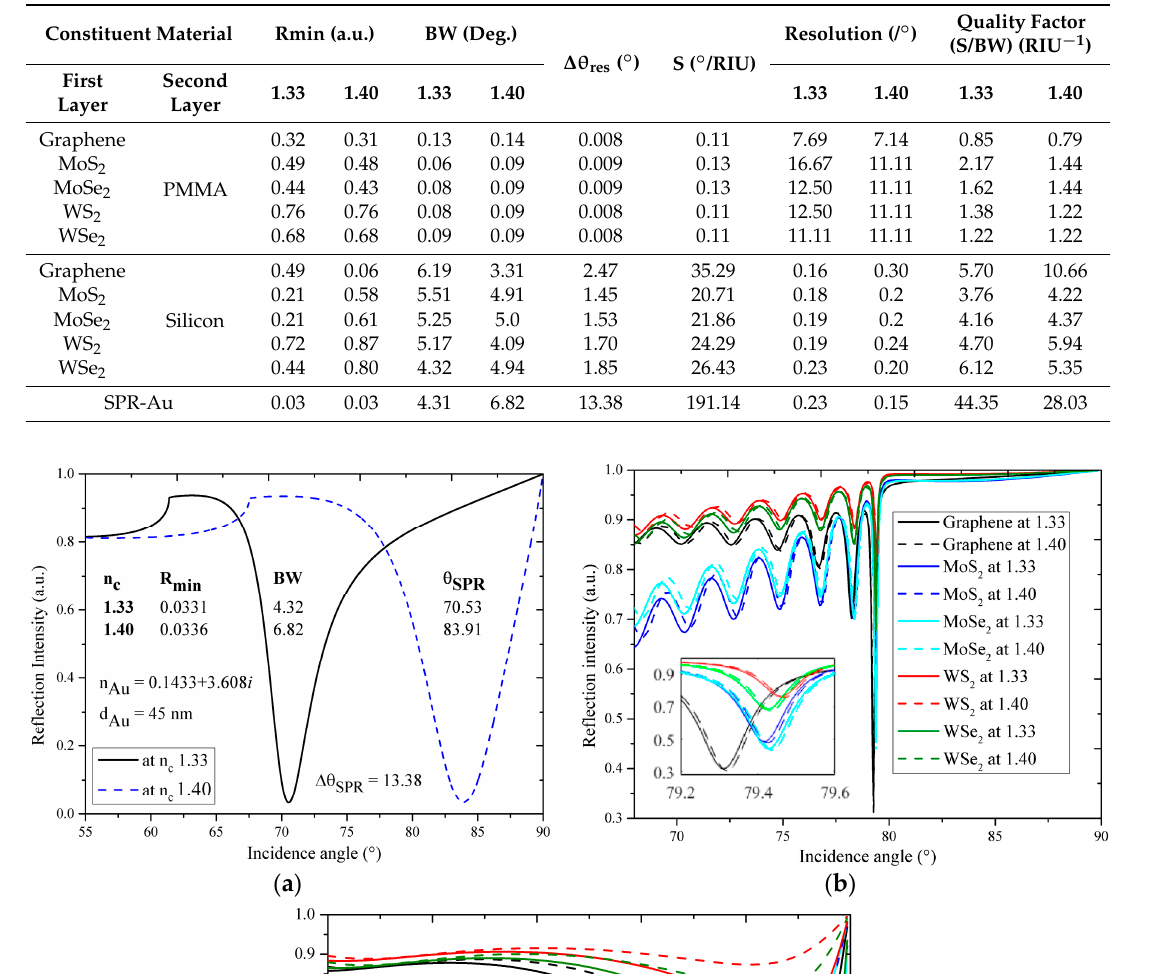
Table 1. Arrangement of obtained value of the minimum refractive intensity (Rmin) and beam width (BW) at 1.33 and 1.40, and ∆θ res corresponding to ∆ n = 1.40 − 1.33 = 0.07. On the basis of these values the calculated values of S, resolution, and quality factor are also arranged. Constituent Material Rmin (a.u.) BW (Deg.)